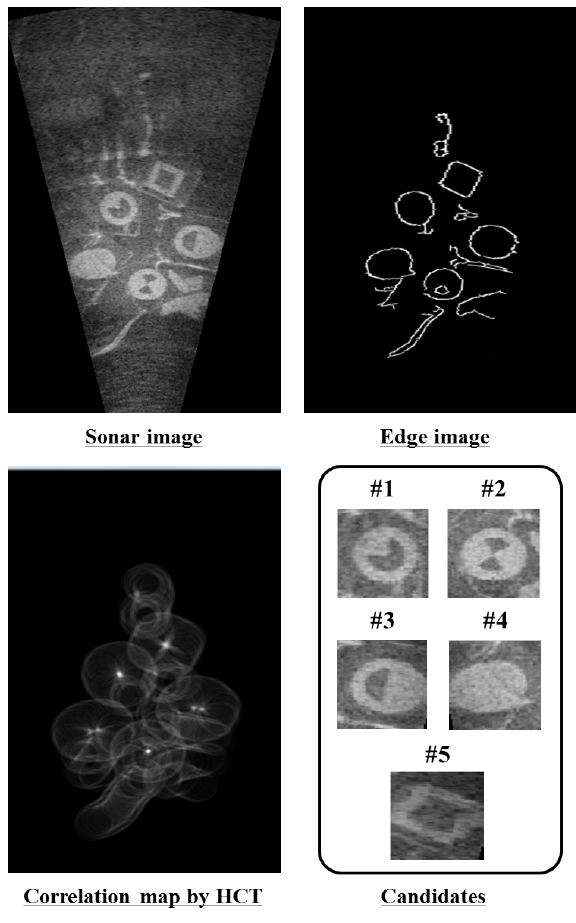
Figure 7. Experimental example of selection of